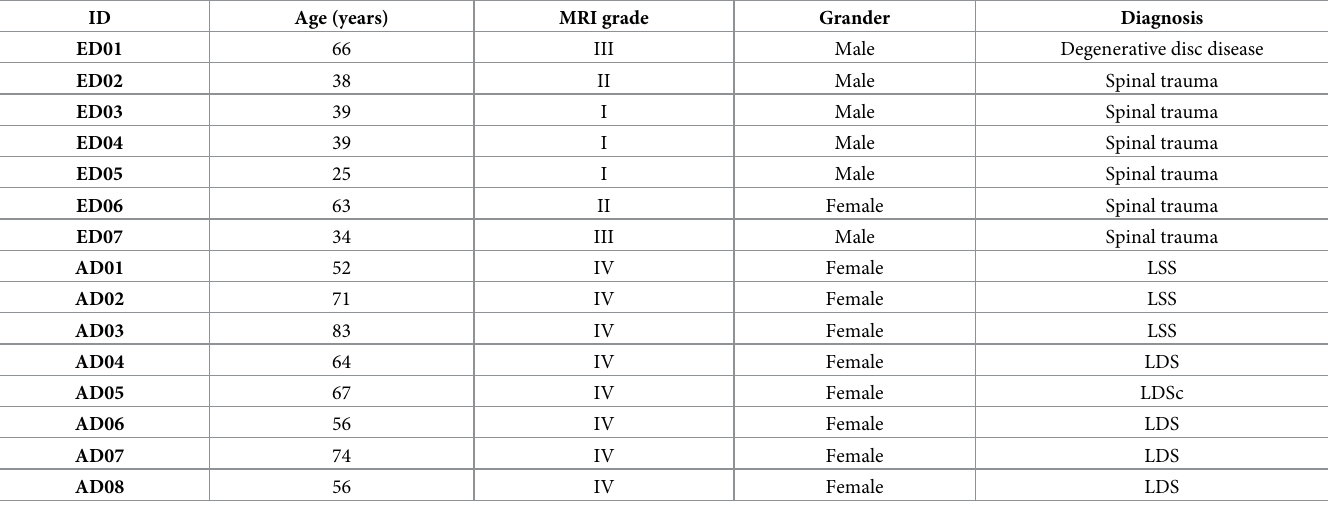
Table 1. Patient